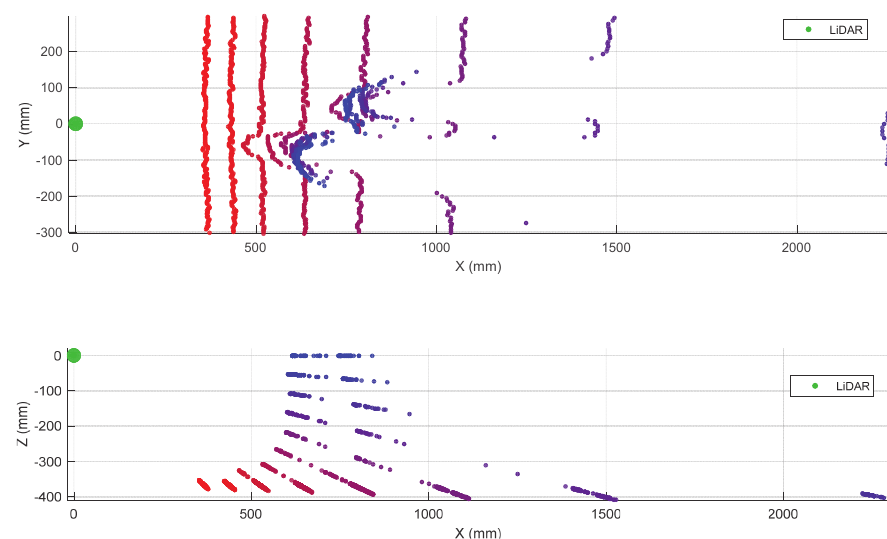
Figure 4. Top (up) and lateral (down) view of the different scans obtained when placing one shoe/leg at a fixed distance from the LIDAR. The tilt of the LIDAR has been changed from 0° (horizontal) to 45° in increments of 5°. Table 3. One shoe/leg detection results obtained for different distance and LIDAR tilt angles: ( (cid:454) ) object detected, (R) object detected after ground reflection, (-) object not detected.